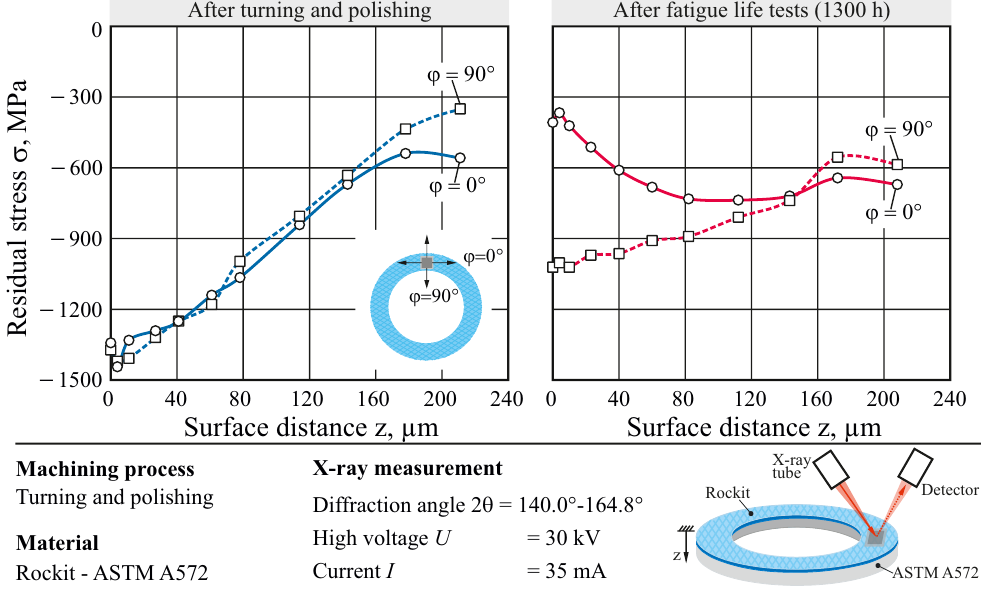
Figure 7. Residual stress depth profiles after machining ( left ) and after fatigue life tests ( right ).